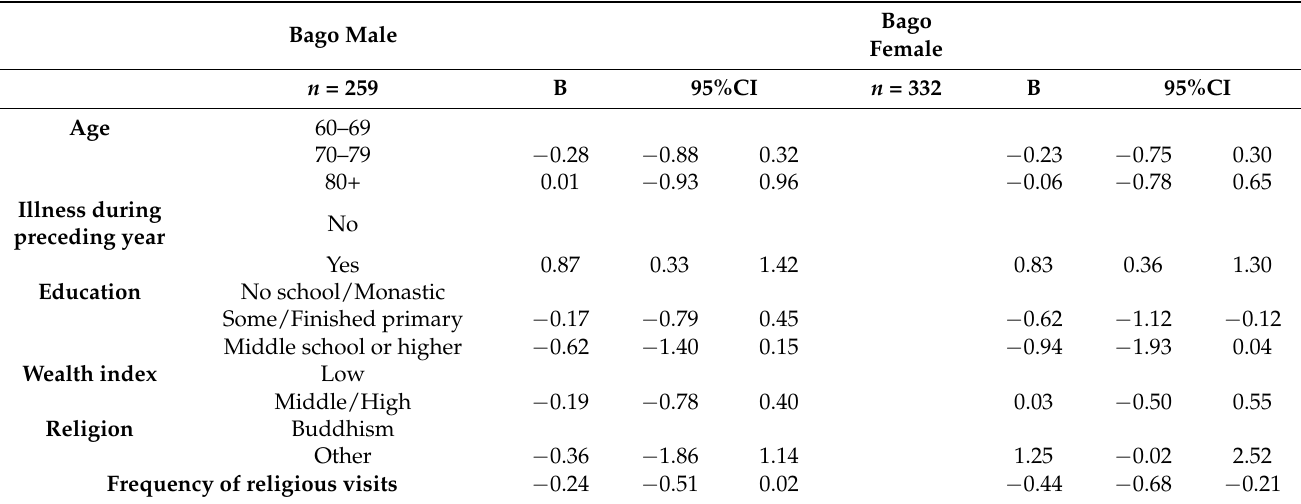
Table 4. Multivariate adjusted association between sociodemographic factors and Geriatric Depression Scale scores among the rural male & female older